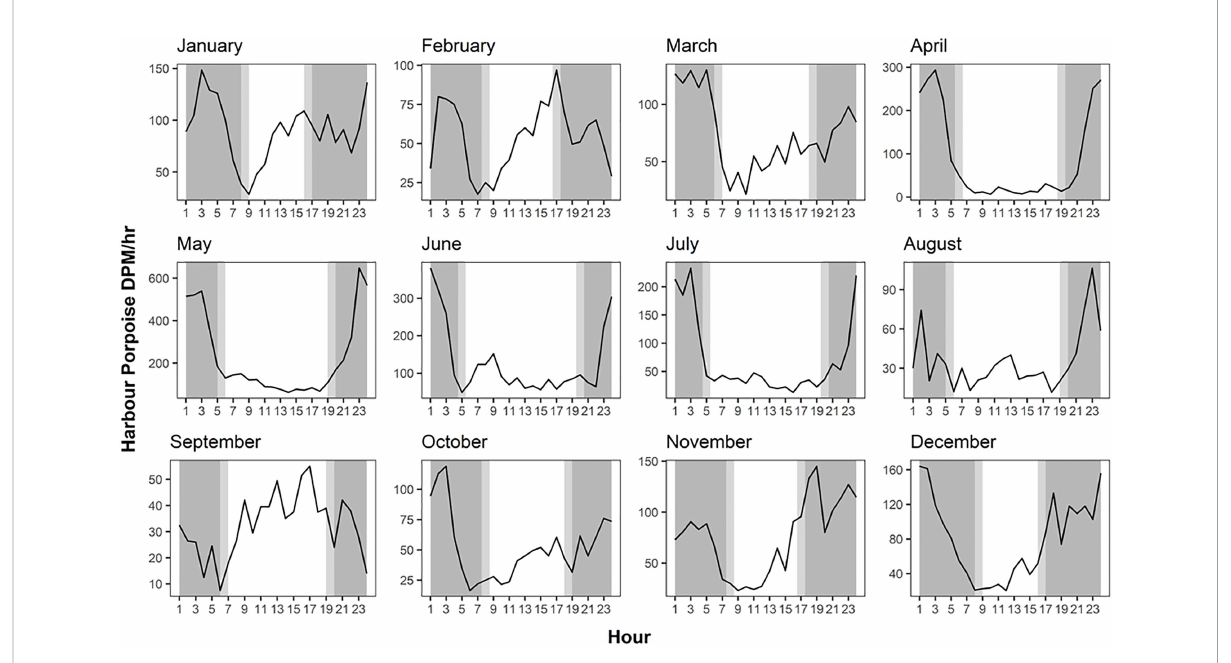
FIGURE 5 Hourly variation in mean harbour porpoise Detection Positive Minutes (DPM) across months for F-POD data. Data for 2020 and 2021